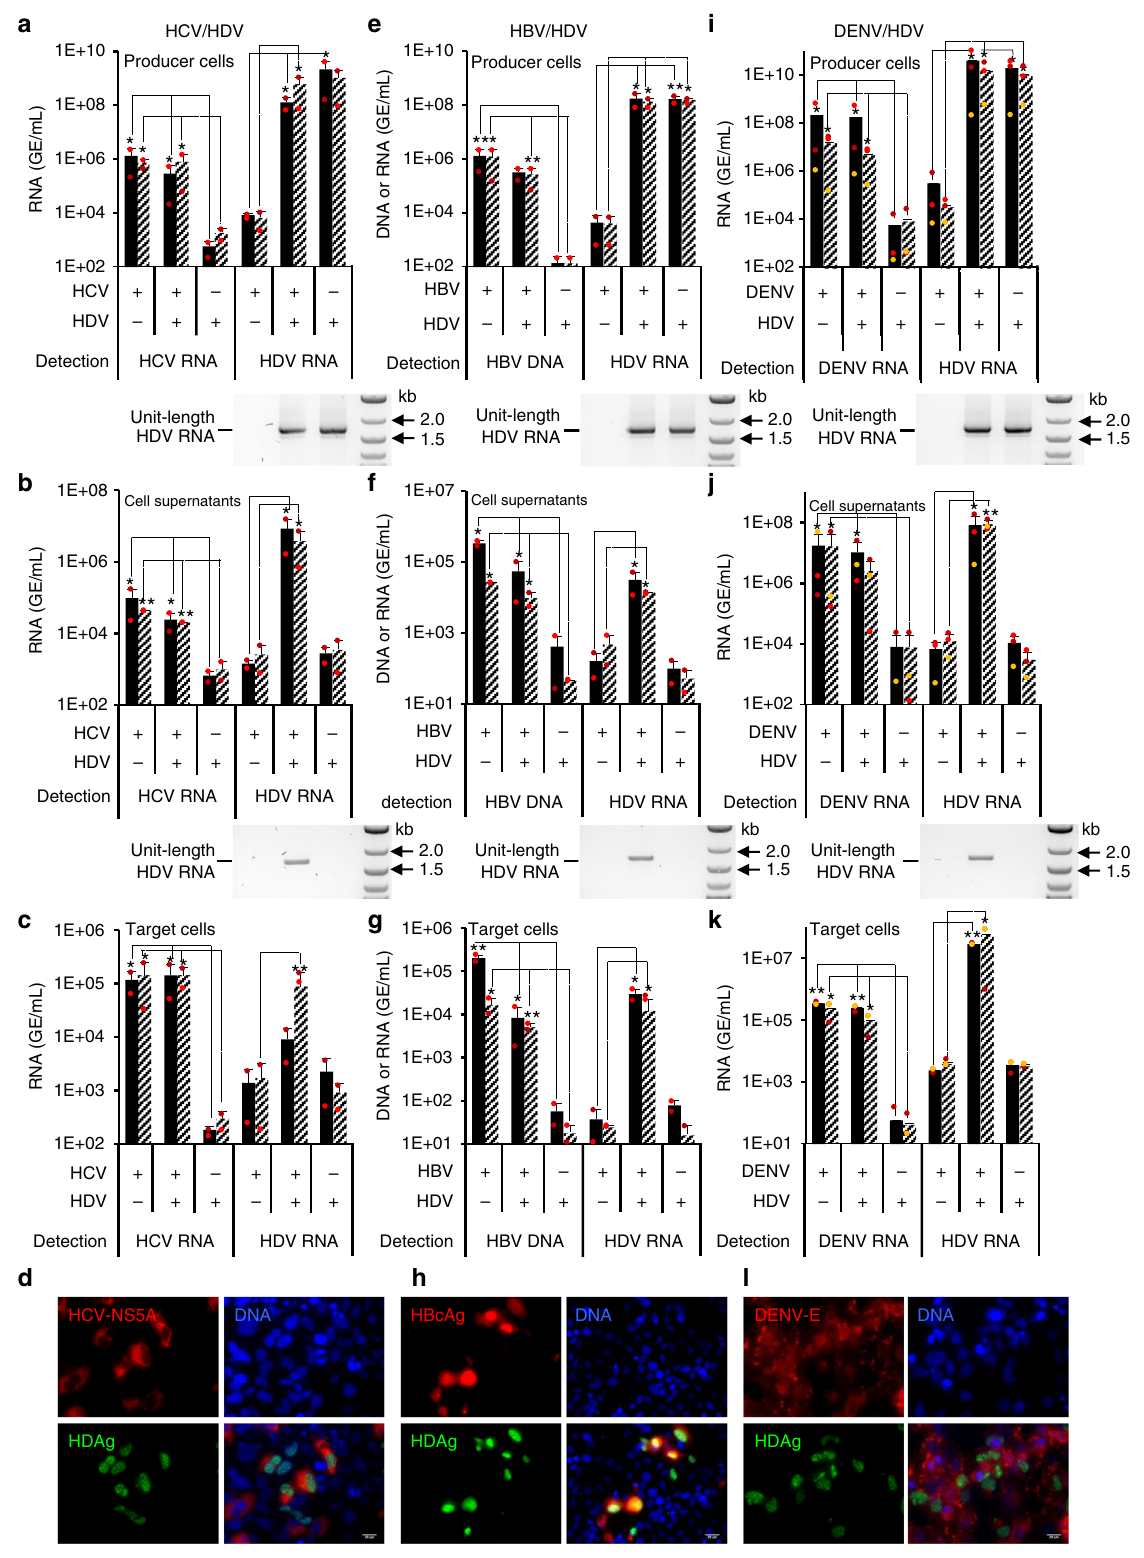
HuHep-mice (5 – 8 animals each) were inoculated with either “ helper-free ” HDV followed by HCV 4 weeks later